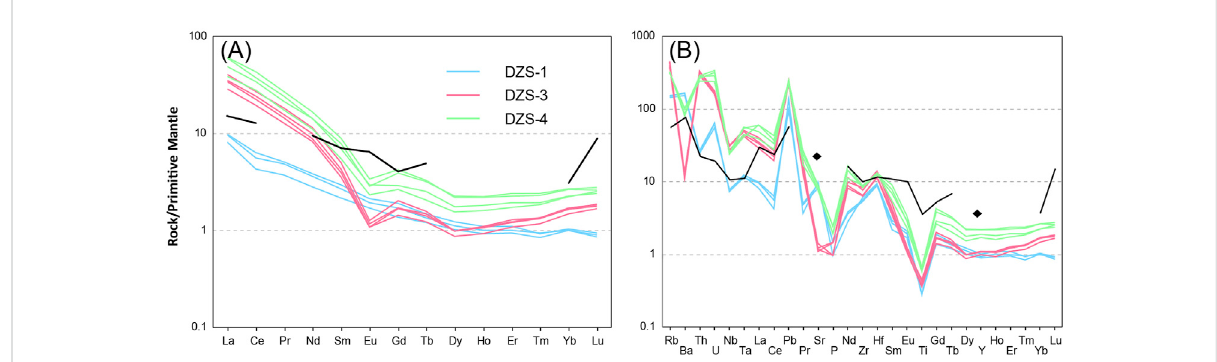
FIGURE 6 Primitivemantle-normalizedREEpatterns (A) andtraceelementvariationdiagrams (B) forthequartzporphyry,rhyoliteporphyry,andDazeshan biotite granite. The normalization values are from McDonough and Sun (1995). Black line: average granulite terrane/xenolith concentrations in the NCC (Jahn and Zhang, 1984; Liu et al., 2001; Zhai et al.,